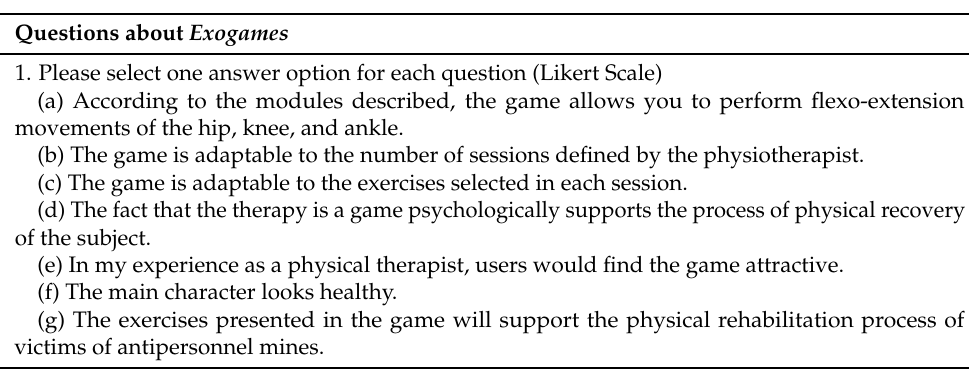
Table 5. Exogames